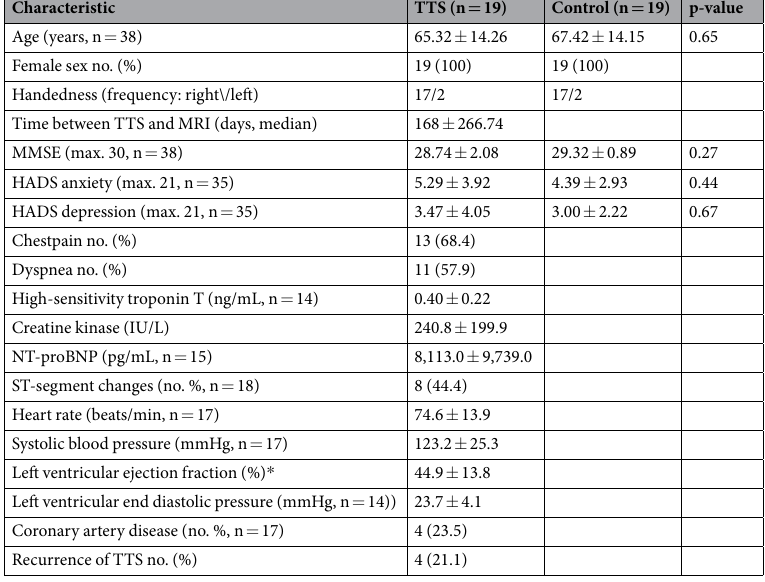
Table 1. Demographic, clinical and behavioural characteristics. Characteristics were compared between groups using two-sample t-Tests. Plus-minus values are means ± standard deviation. Abbreviations: HADS, Hospital anxiety and depression scale; MMSE, mini mental state examination; max., maximum; n, number of subjects. * Data regarding the left ventricular ejection fraction were obtained either during catheterization or echocardiography. If both results were available, data obtained during catheterization are